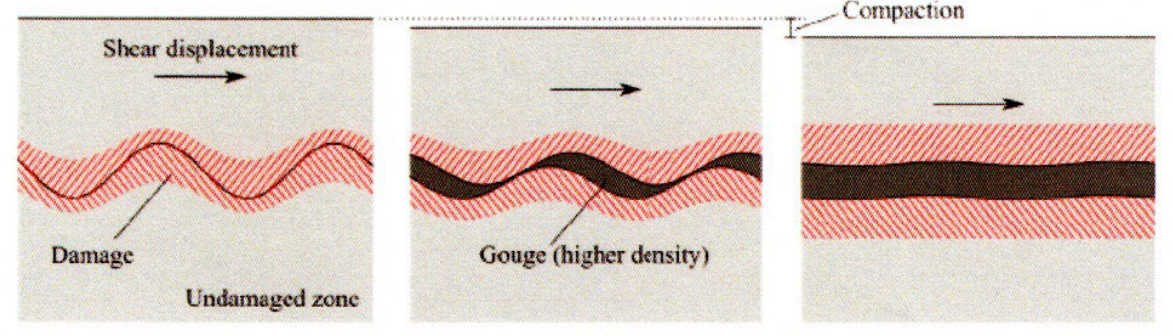
Figure 6 : Schematic representation of gradual wear of asperities. Abraded grains form a gouge layer between the interfaces (after Braun et al. 2021).